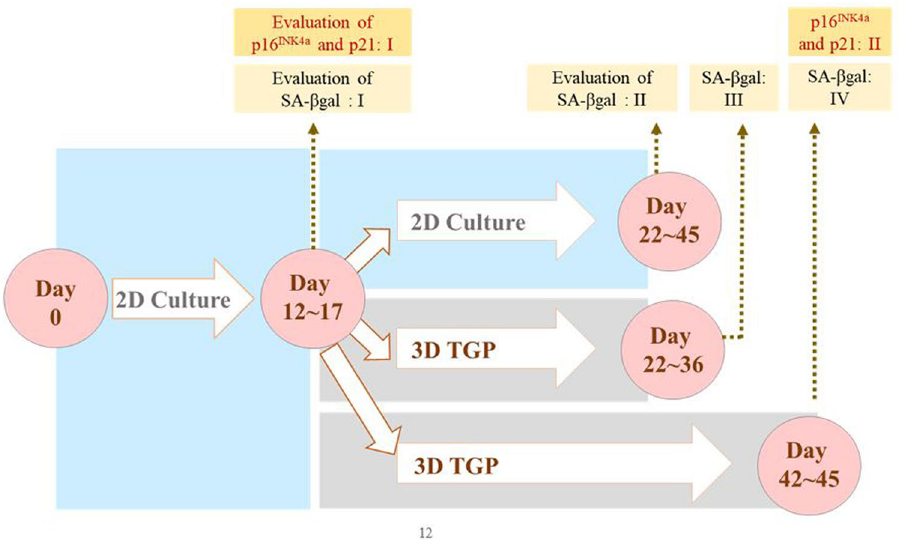
Figure 1. Illustration of the study groups and time-points of evaluation of SA-βgal, p16INK4a and p21 in two- dimensional (2D) and three-dimensional (3D) thermo-reversible gelation polymer (3D-TGP)